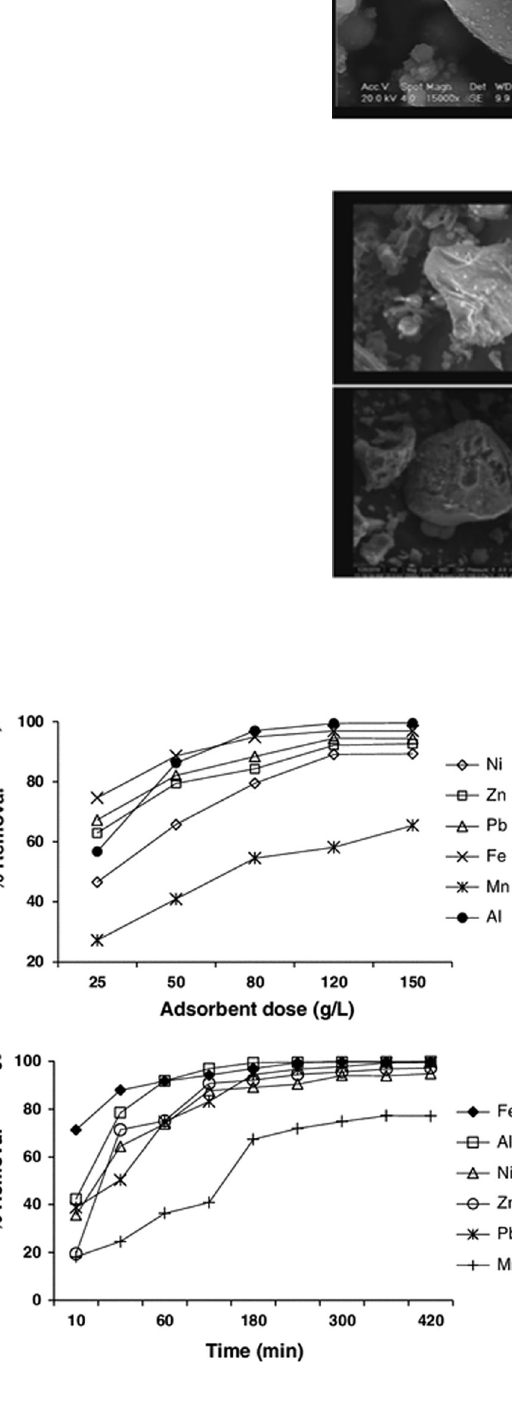
Fig. 6 Effect of the adsorbent dose on metal removal by MFA at 3-h contact time a and effect of contact time on metal adsorption onto MFA b (Sahoo et al. 2013)